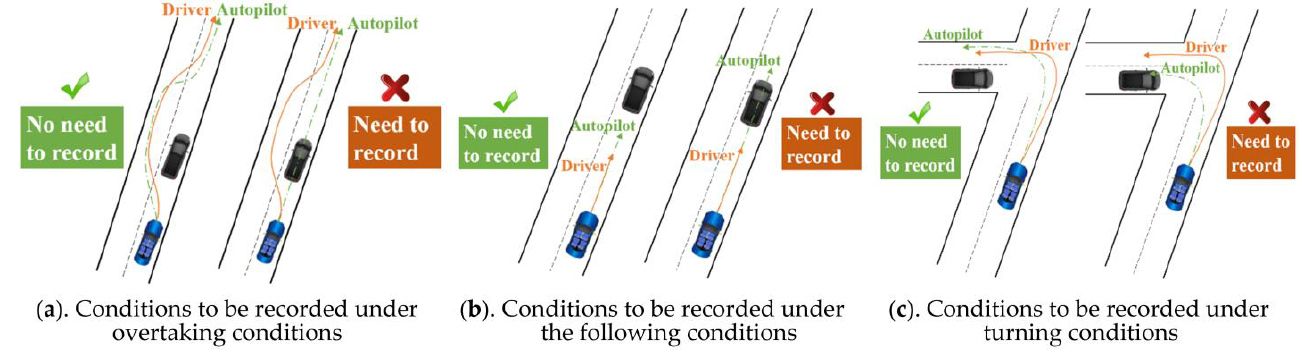
Figure 5. E xamples of scenarios where data needs to be recorded.